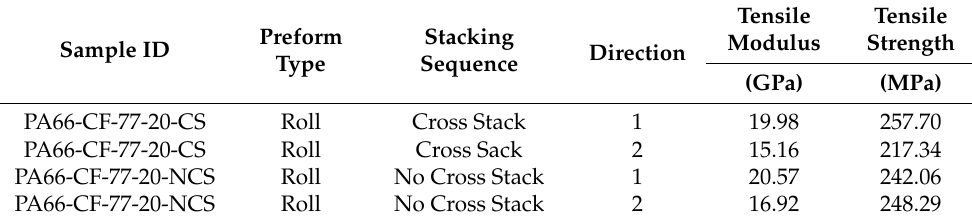
Table 6. Tensile modulus and strength of PA66-CF (preform ‘Roll’).